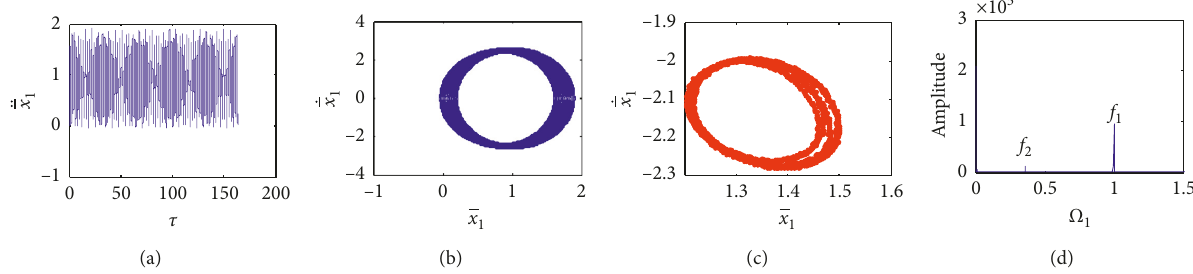
Figure 14: Vibration characteristics when Ω � 3: (a) time domain, (b) phase diagram, (c) Poincar´e section, and (d) frequency 1